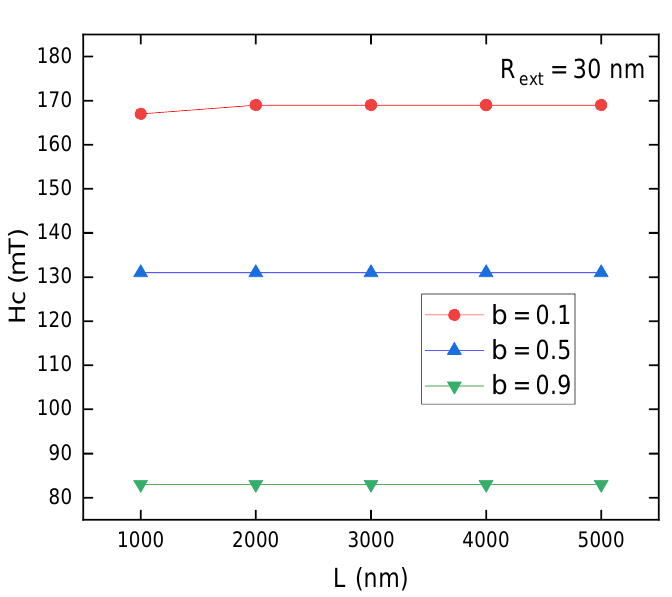
Figure A1. Coercivity for long Fe 3 O 4 nanotubes with an external radius of 30 nm and three different hole sizes, β = 0.1, 0.5, and 0.9, with lengths ranging between 1000 and 5000 nm, when the external magnetic field is applied along the z -axis.